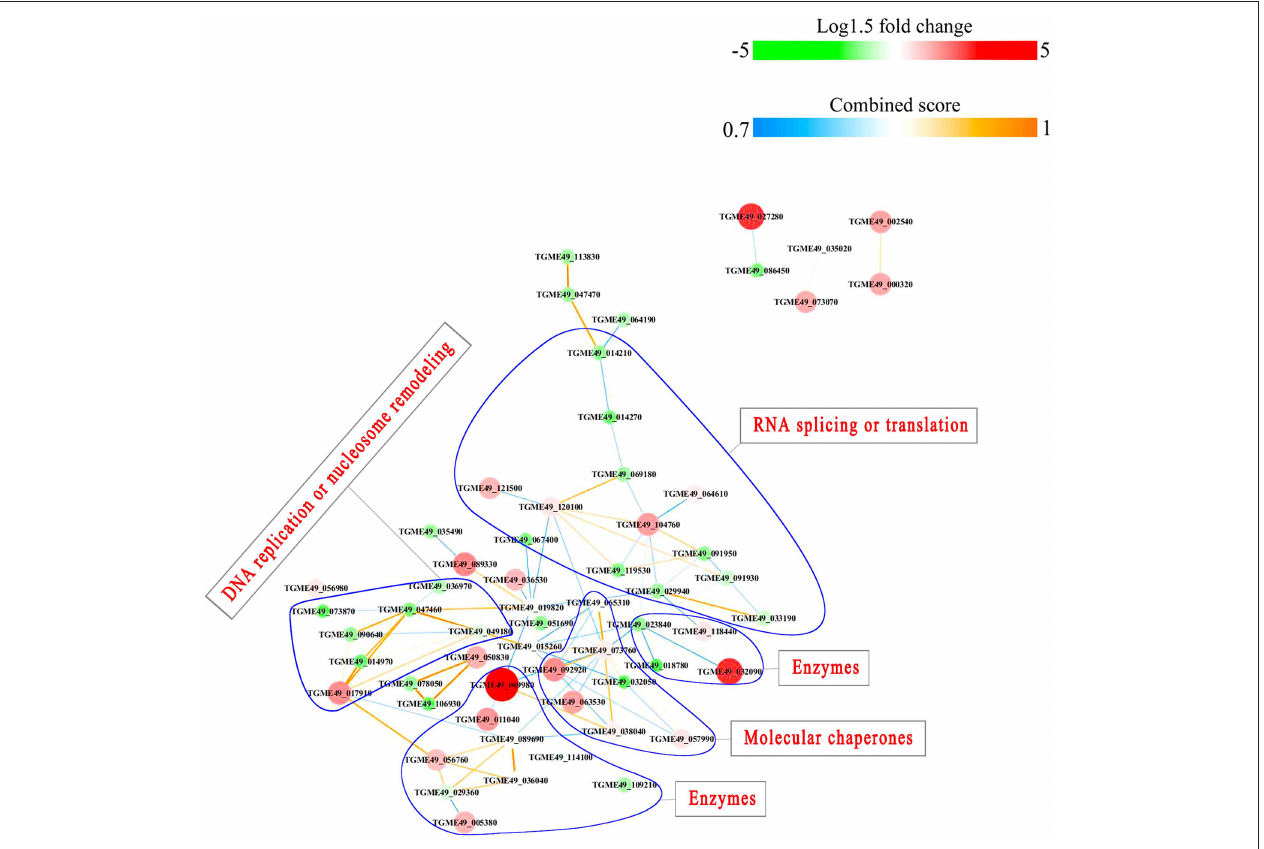
FIGURE 11 | Interaction network of the phosphoproteins up/down-regulated in PRU strain when comparing PRU/PYS strains. Nodes represent phosphoproteins and edges denote interactors between phosphoproteins. The upregulation and downregulation of phosphoproteins were characterized by the color and size of nodes. Red and large size nodes represent up-regulated phosphoproteins in PRU, whereas green and small size nodes denote down-regulated phosphoproteins in PRU. The color of edge represents the combined score of interactors.